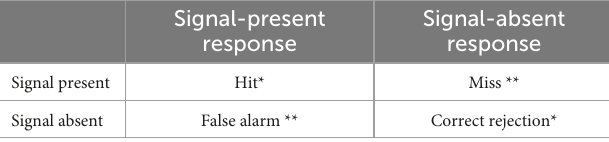
TABLE 1 Type-1 SDT categories for signal responses as related to signal presence, * and ** denote the correct and incorrect type-1 responses. Signal-present response